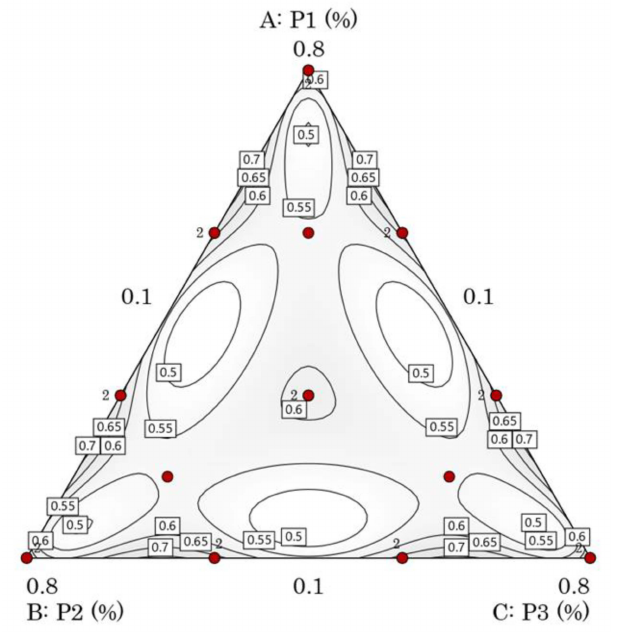
Figure 5. Geometric location of the experimental points of the optimal mixing